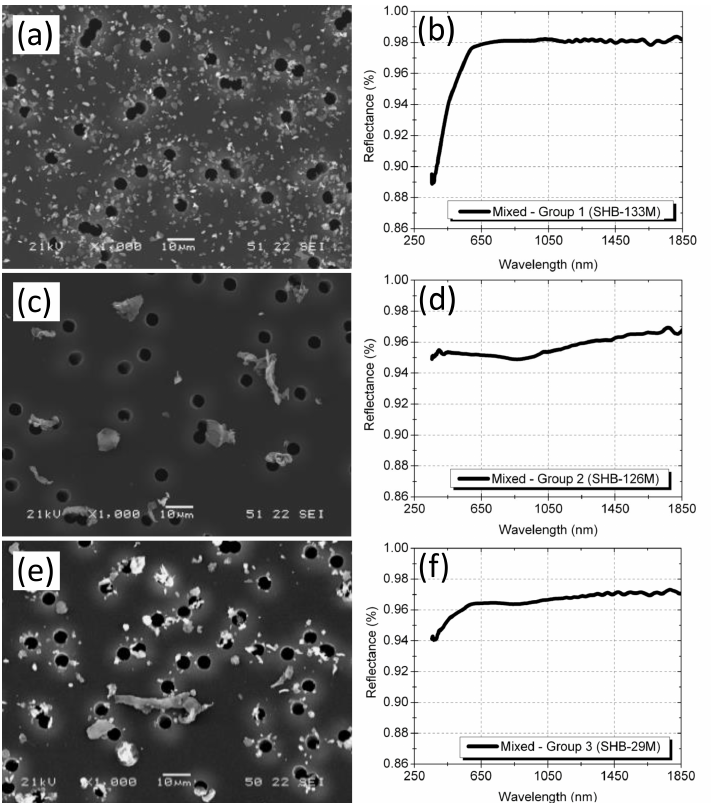
Figure 6. Examples of spectral reflectance and SEM images of Saharan dust from SS2 in Mauritania for (a, b) group 1, (c, d) group 2, and (e, f) group 3. Each curve represents the average over 25 measurements of reflectance over the same filter. Uncertainties on the reflectance were estimated to be of a maximum of 2.0% for the full wavelength range. The scale bar in the SEM images shows a 10µm scale for size reference. The samples were collected on 21 June, 19 June, and 26 May